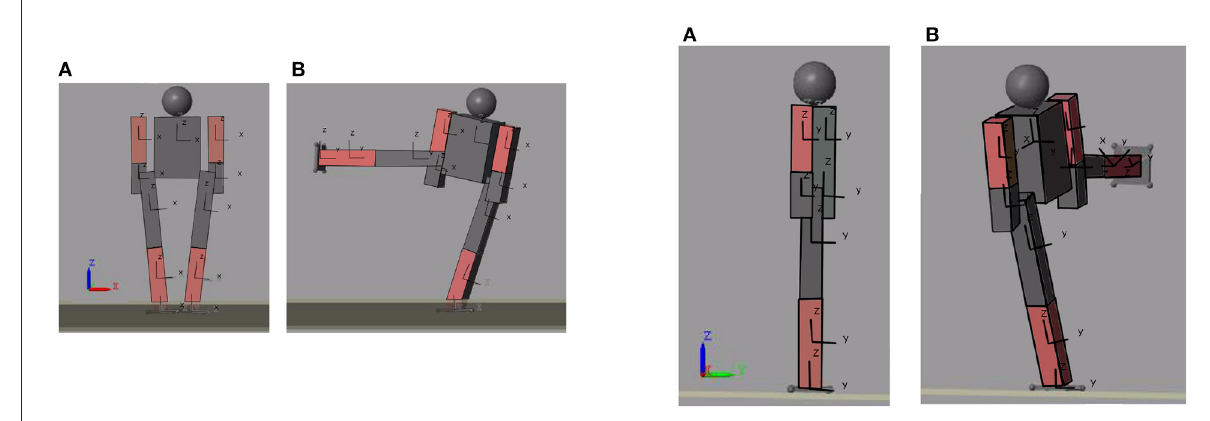
FIGURE12 Initial and final position of the biped seen in the XZ (left– A,B ) and YZ (right– A,B ) planes for ground tilt.